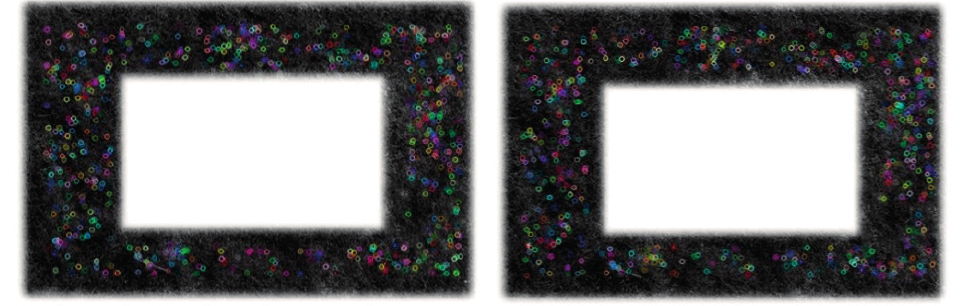
Figure 4. Feature extraction results of the reference frame ( Left ) and one of sequence frames ( Right ).